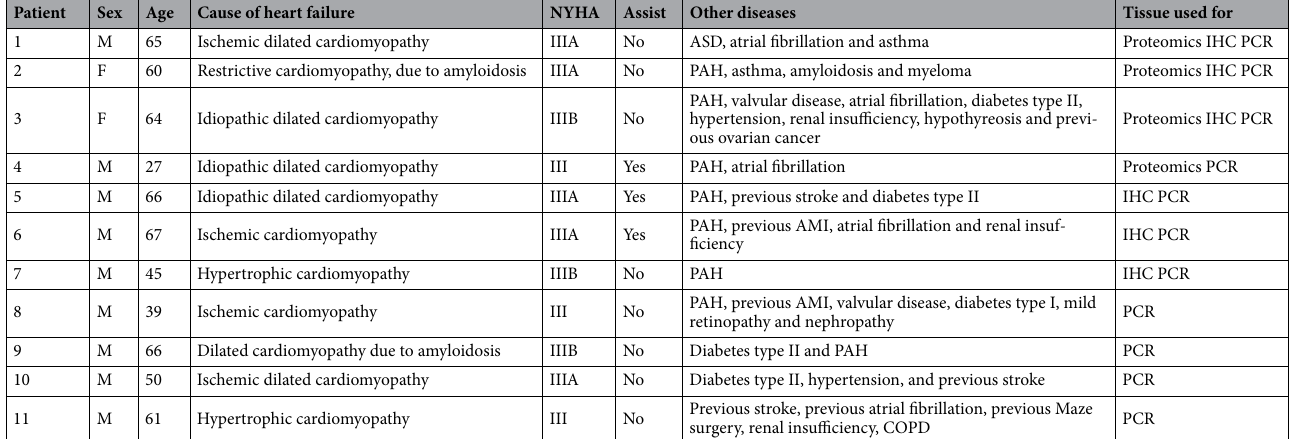
Table 2. Clinical background of patients with terminal heart failure. Table summarizes the clinical background of the included patients that underwent cardiac transplantation due to heart failure. F = female, M = Male, NYHA = New York Heart Association, PAH = Pulmonary Arterial Hypertension, AMI = Acute Myocardial Infarction, ASD = Atrial Septum Deficiency, COPD = Chronic Obstructive Pulmonary Disease, Assist = mechanical assist (i.e. LVAD / BiVAD), LVAD = Left Ventricular Assist Device, Proteomics = Global Quantitative proteomics, IHC = Immunohistochemistry, PCR = Polymerase chain